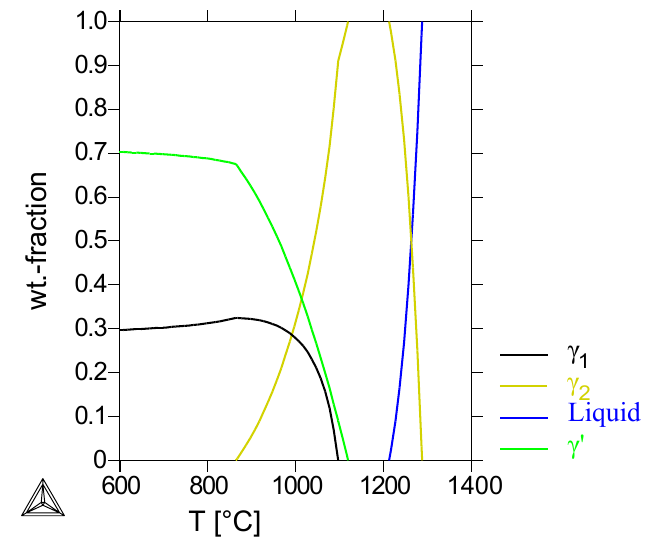
Figure 11. Thermo-Calc calculations for the alloy Ni-30%Cu-6%Al-5%Cr.